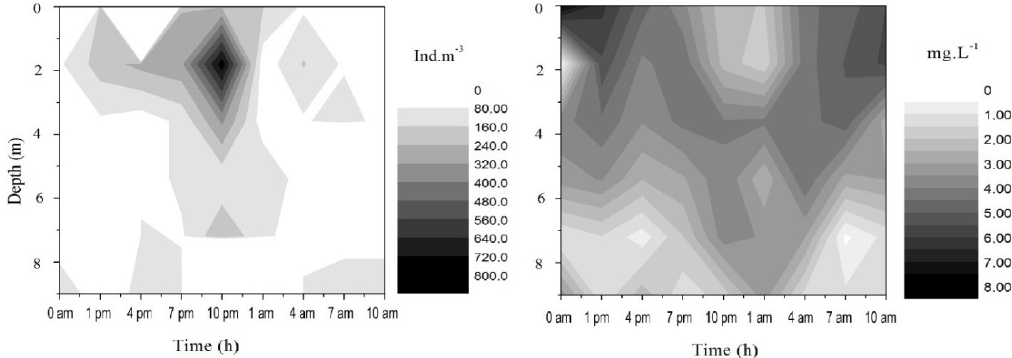
Figure 6. Vertical variation in population density of Chaoborus sp (ind.m -3 ) and Chlorophyll a concentration ( mg L -1 ) during a single nictemeral cycle, at a study station in Furnas Reservoir, from 10 am of January 15 to 10 am of January 16, 2014.